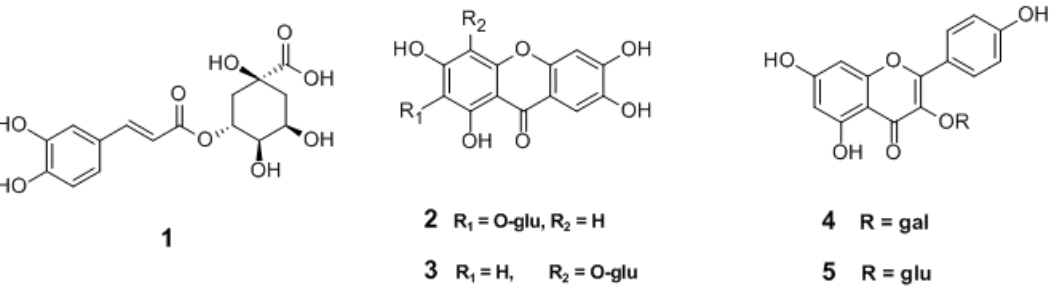
Figure 2. Chemical structures of compounds 1 – 5 ( 1 . chlorogenic acid; 2 . mangiferin; 3 . isomangiferin; 4 . trifolin; 5 . astragalin).